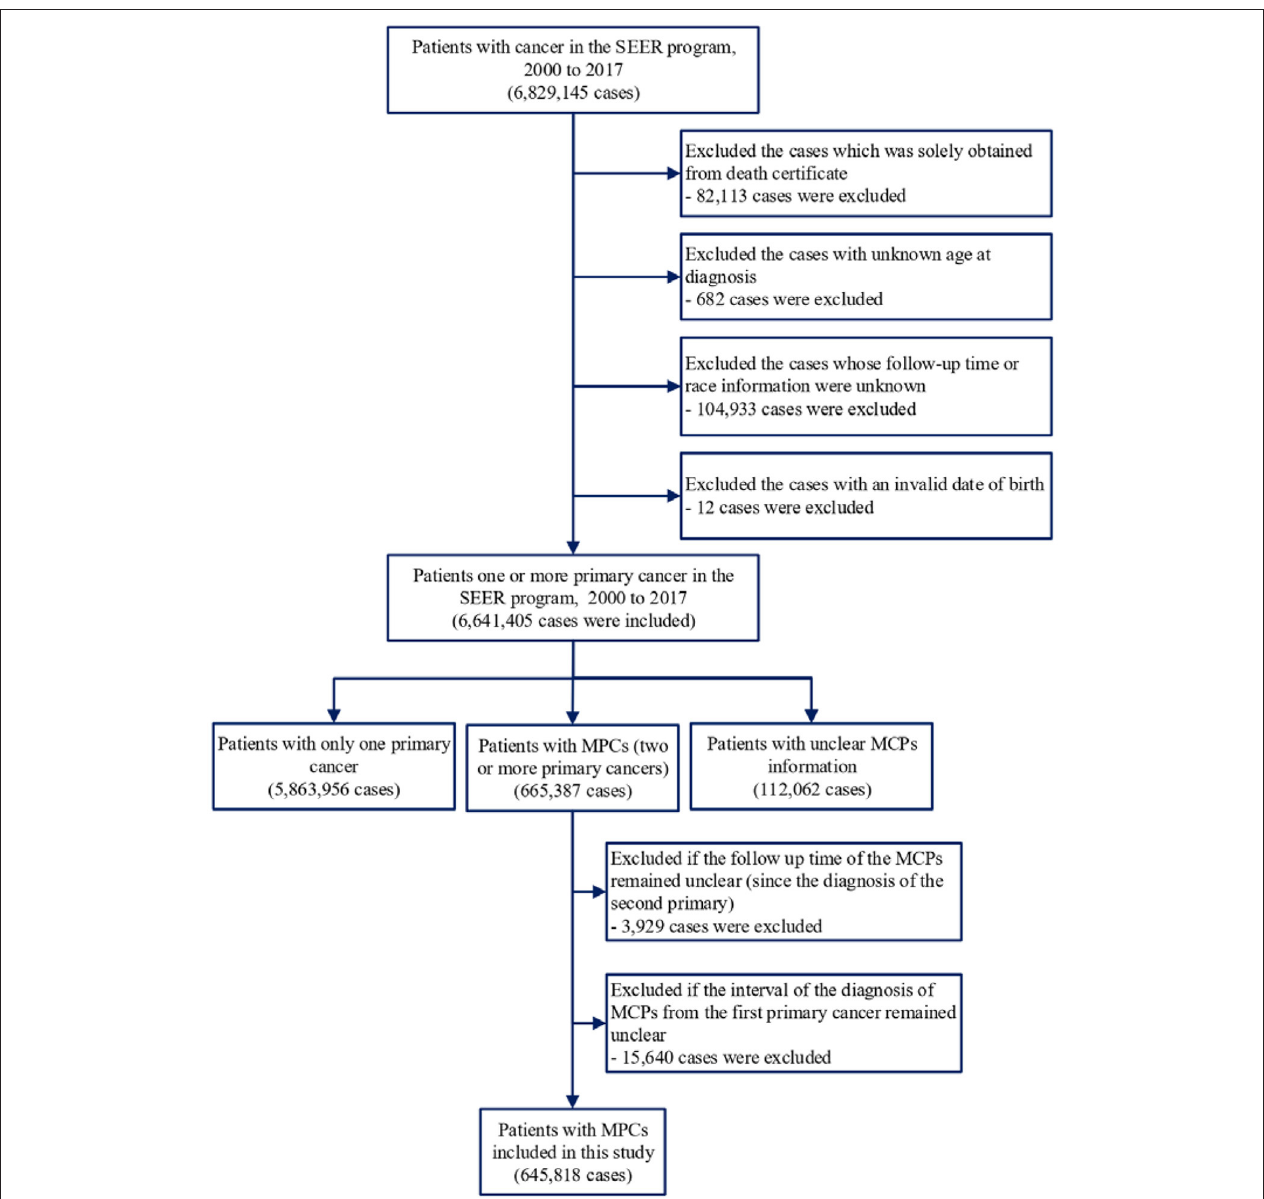
FIGURE 1 | Inclusion and exclusion criteria for patients included in this